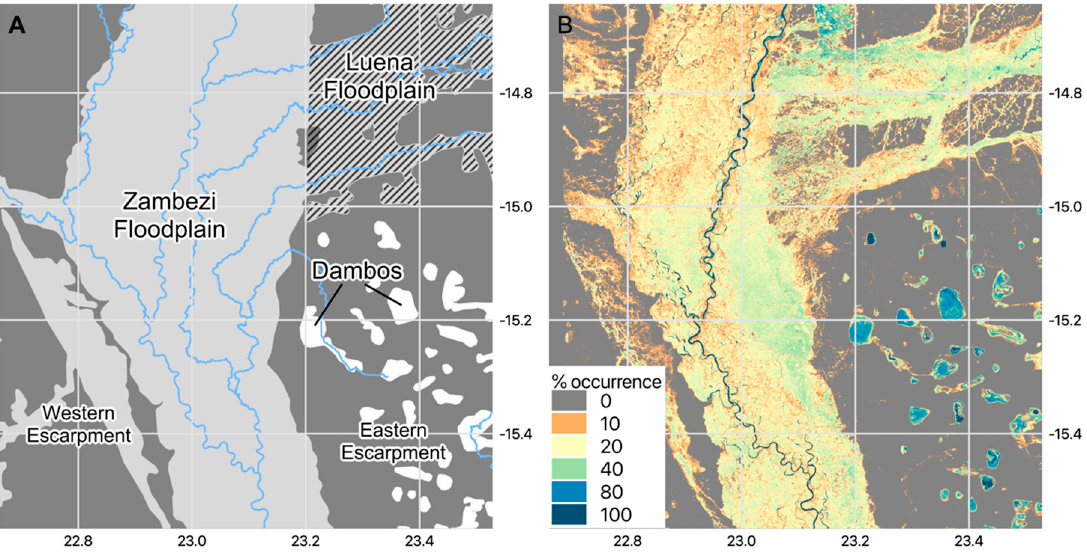
Figure 12. Water body extent derived from classified Sentinel-1 images for Barotseland over the study period.